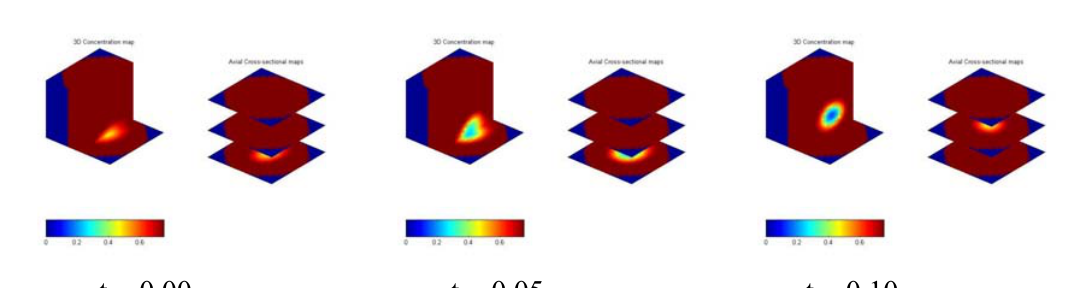
Figure 16. Snapshots of a single bubble rising in a bubble column with Paratherm fluid by ECVT.